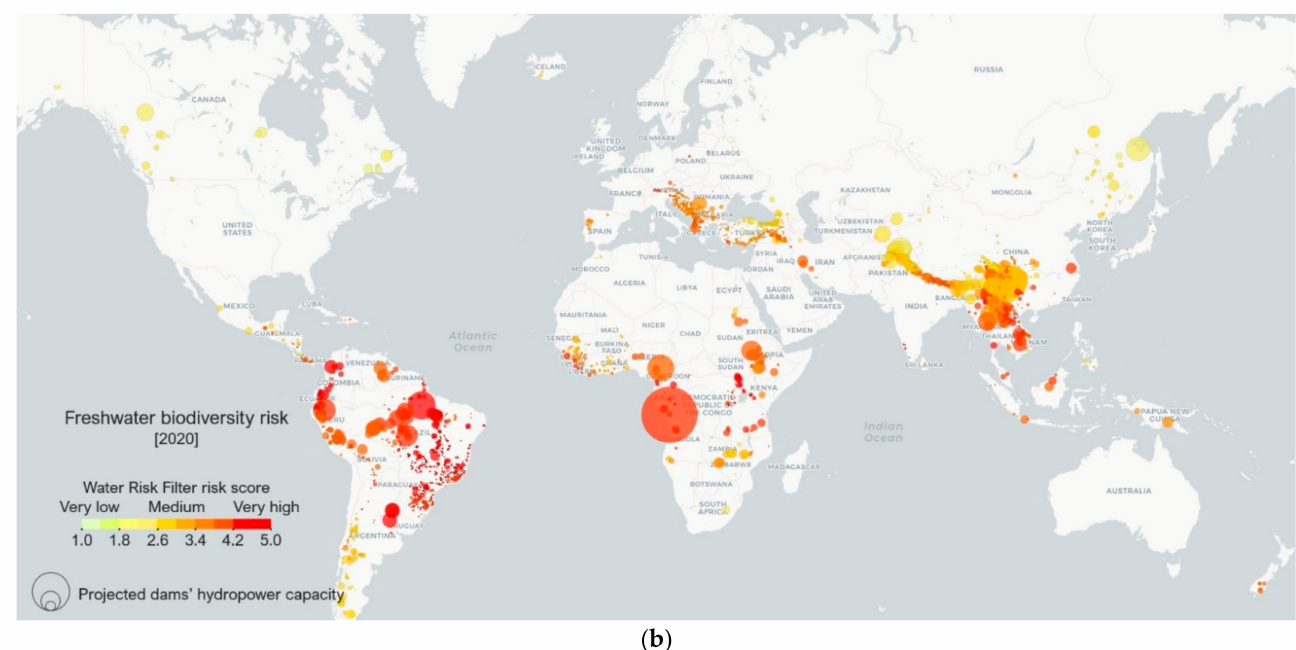
Figure 14. ( a ) Existing hydropower dams with color indicating biodiversity risk (based on species richness and endemism of freshwater fish in the dam’s river basin). The size of the circle indicates the hydropower capacity of the dam. ( b ) Projected hydropower dams with color indicating biodiversity risk (based on species richness and endemism of freshwater fish in the dam’s river basin). The size of circles indicates hydropower capacity. See the interactive version of these maps at https: //rcamargo.shinyapps.io/HydropowerClimateChange; (accessed 21 January 2022).